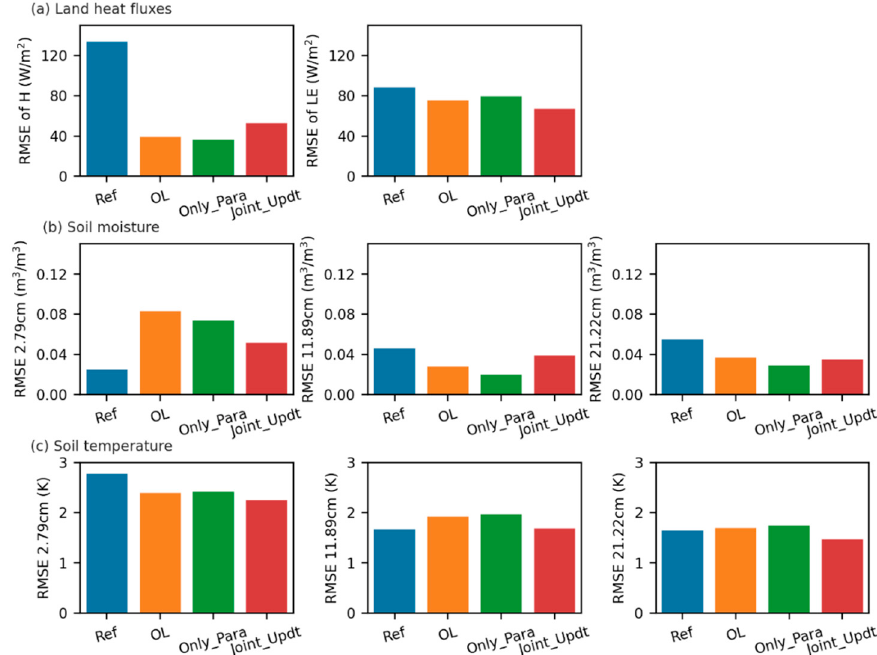
Figure 8. RMSE values of the land state and flux variables for the reference (Ref) experiment, open loop (OL) experiment, experiment with only soil properties updated (Only_Para) and experiment with both soil properties and soil moisture estimates (Joint_Updt) by assimilating SMAP T H over assimilation period (from 8 August 2016 to 31 August 2016), in comparison to the in situ observations (i.e., profile soil moisture and temperature measurements and the turbulent heat fluxes measurements by eddy-covariance system deployed at the Maqu site [38]). ( a ) is for land latent heat flux (LE) and sensible heat flux (H), and ( b ) and ( c ) are for soil moisture and soil temperature at different depths,